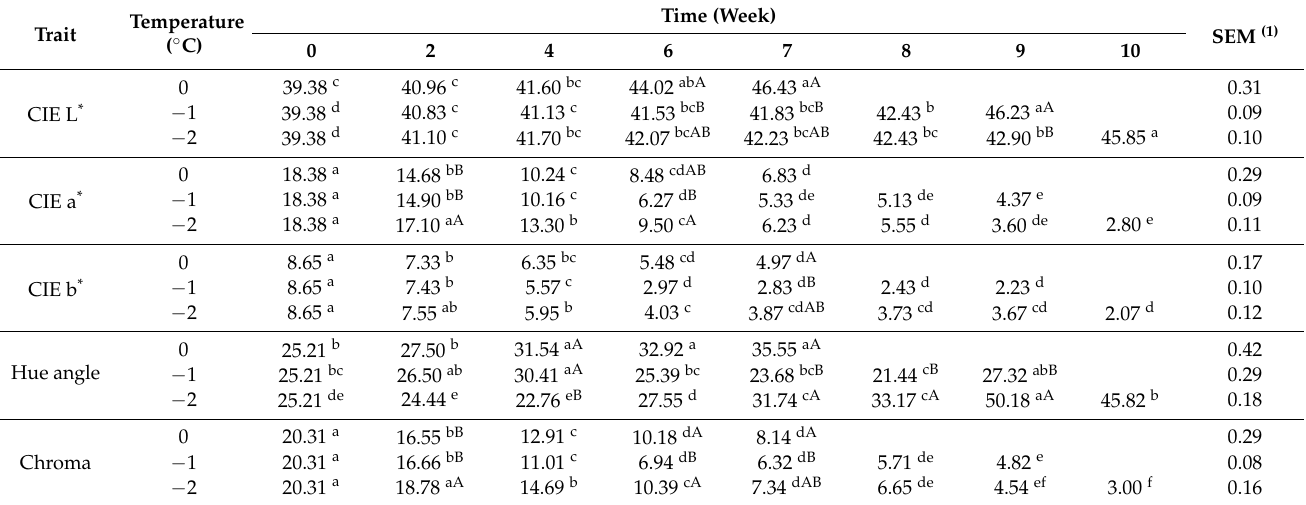
Table 3. Color of dry-aged beef loin on 0, − 1, − 2 ◦ C temperature electric field refrigerate system.